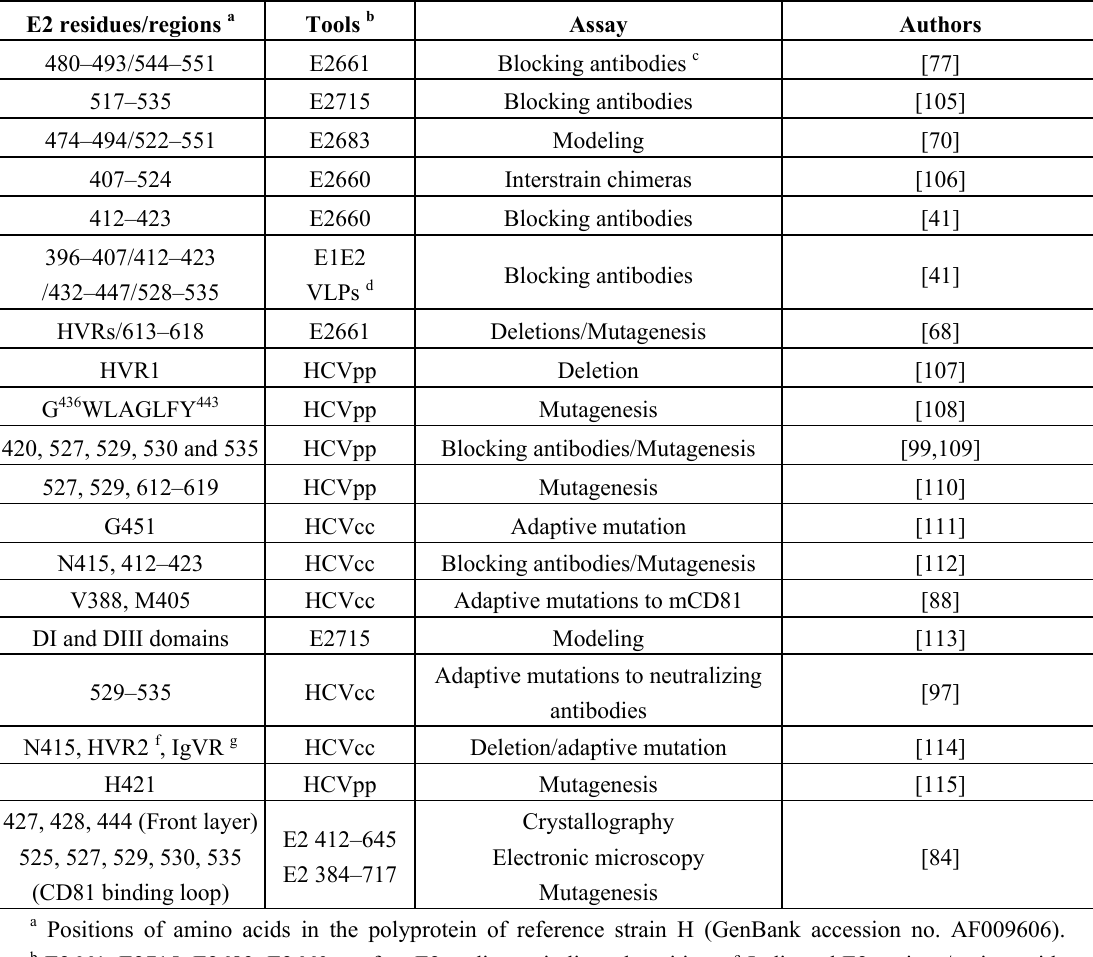
Table 1. HCV E2 amino acids potentially involved in CD81